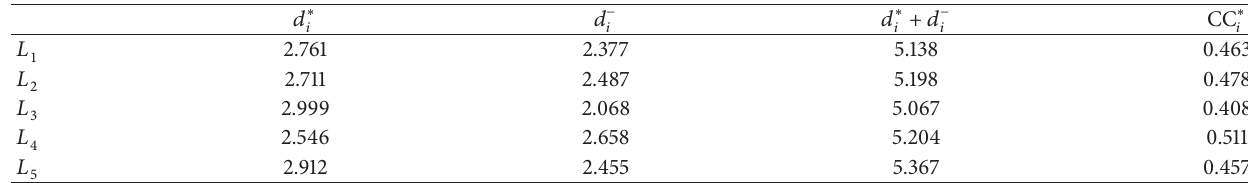
Table 10: Computations of 𝑑 ∗ 𝑖 , 𝑑 − 𝑖 , and CC ∗ 𝑖